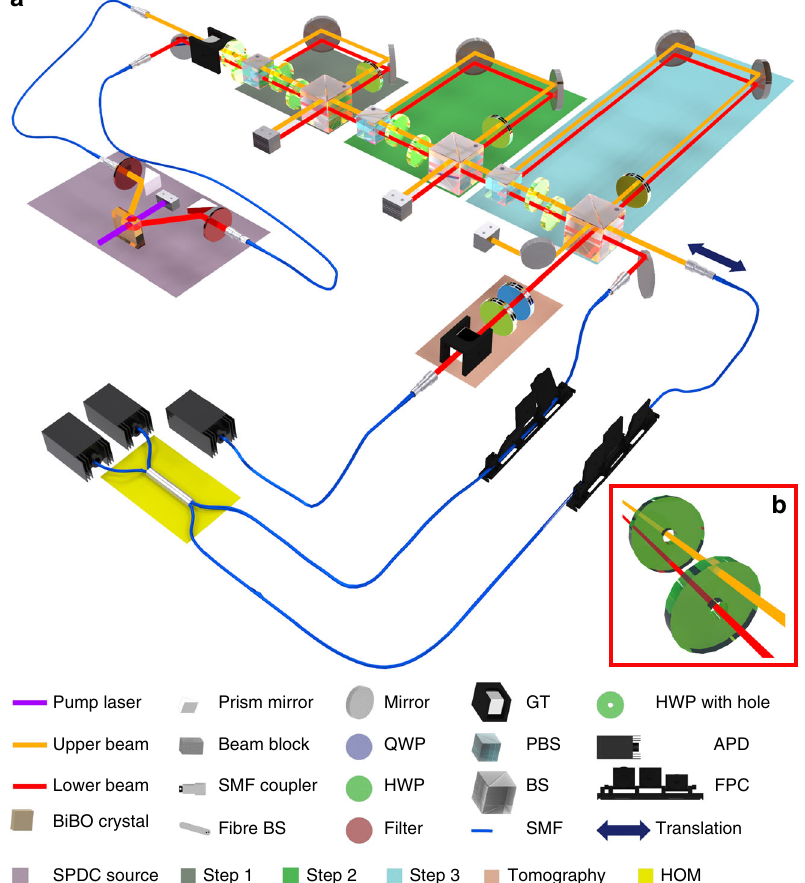
Fig. 3 Experimental setup. a Single photons are generated from a degenerate spontaneous parametric down-conversion (SPDC) source pumped by a 410 nm continuous-wave laser. After fi ltering the generated photons with (820 ± 1.5) nm bandpass fi lters, photons in the lower beam (red) and upper beam (orange) are separately prepared in their respective input states, | S 0 〉 or | S 1 〉 , using half-wave plates (HWP). Polarisation qubits, one from each beam, are used as memory states for the simulation of two separate and potentially different processes Π 1 (red) and Π 2 (orange). (For the fi rst experiment described in the text, where only one process is required, the second SPDC output (orange) is sent straight to a heralding detector, rather than through the apparatus.) To implement the three-step simulation, three processor blocks are built — labelled Step 1, Step 2 and Step 3. In each step, path and arrival time modes are also employed to realise the relevant physical operation, as explained further in Methods. The output of one of the simulators (lower beam) is used to perform the polarisation tomography and to measure the arrival times of each photon in order to sample the statistical future. To measure the overlap of the future statistics of two processes, both photons are used, and the other outputs of the third beam splitter (BS) are interfered in a fi bre BS (yellow box). An automated translation stage is used to move one of the couplers in order to vary the relative delay between the single-photon wave packets. Avalanche photodiodes (APD) and a single-photon counting module are used to count the photons. SMF stands for single-mode fi bre, QWP quarter-wave plate, GT Glan-Taylor prism, PBS polarising beam splitter, and FPC fi bre polarisation controller. b The inset shows a close-up of two vertically separated beams passing through two HWPs with holes, each of which only acts on one of the